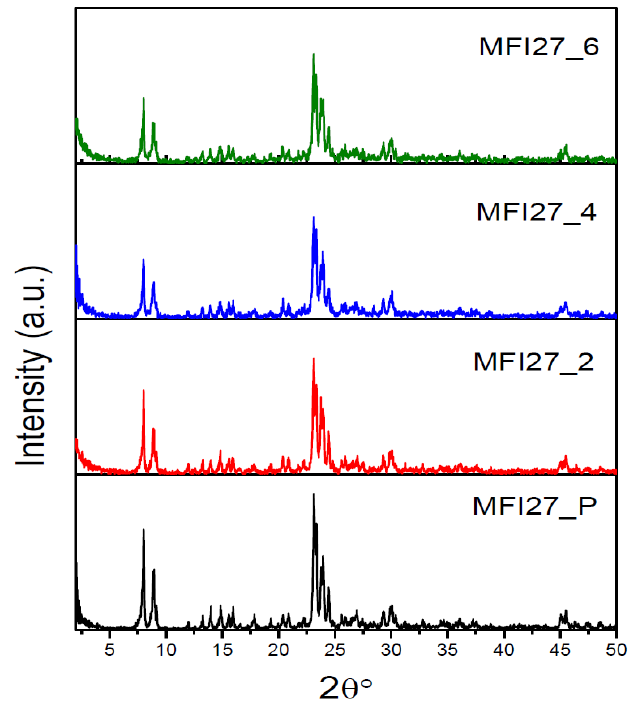
Figure 3. X-ray diffraction patterns for parent and alkali-treated ZSM-5 catalysts.